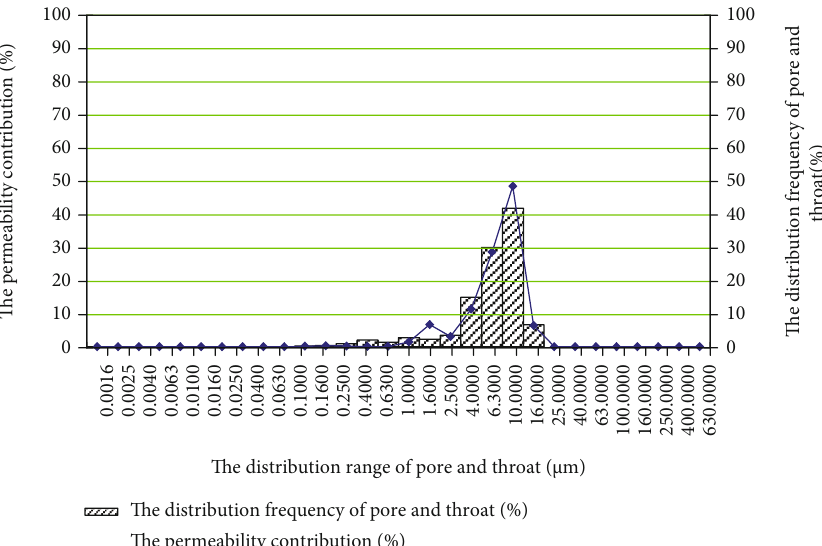
Figure 10: Core pore radius distribution results under the state of hydraulic fracturing by an oil displacement agent (surfactant) with high fl ow rate displacement of core 21-2.